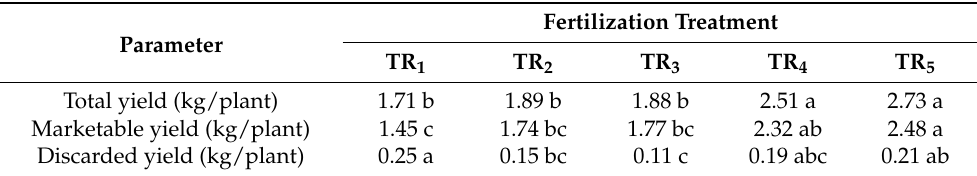
Table 8. Effect of fertilization management strategies on the main quantitative parameters of the processing of tomato crop.